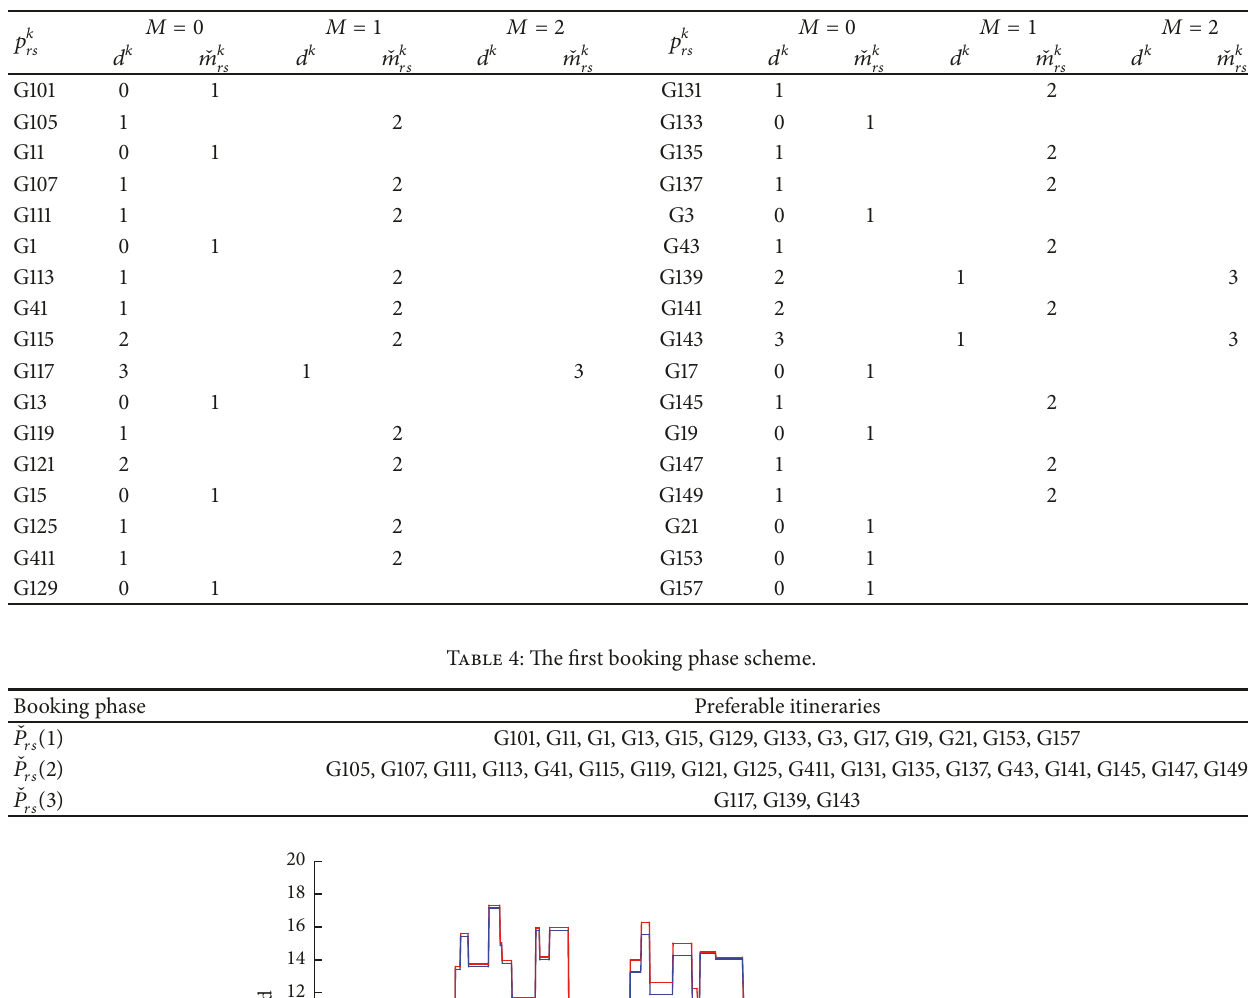
Table 3: The precedence relationship.